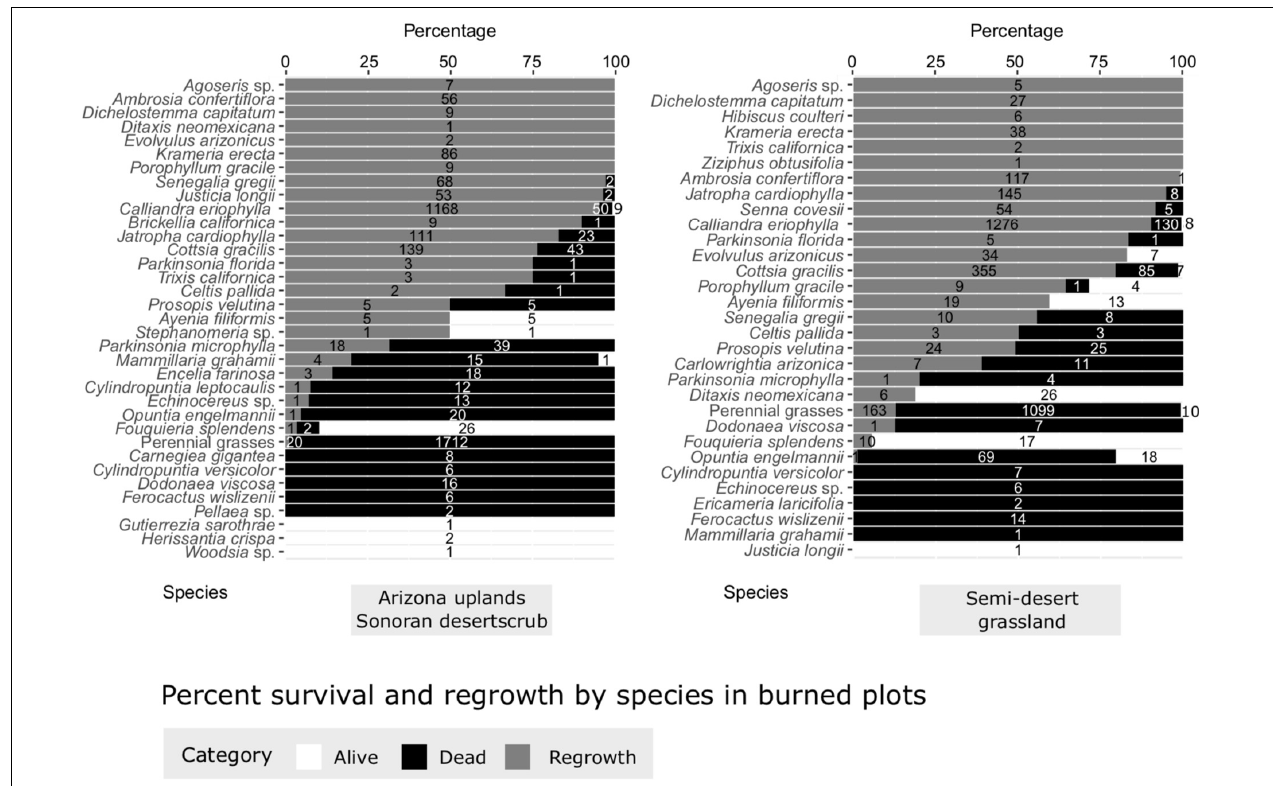
FIGURE 9 | Percent survival and regrowth of species in burned plots, Catalina State Park, Tucson,